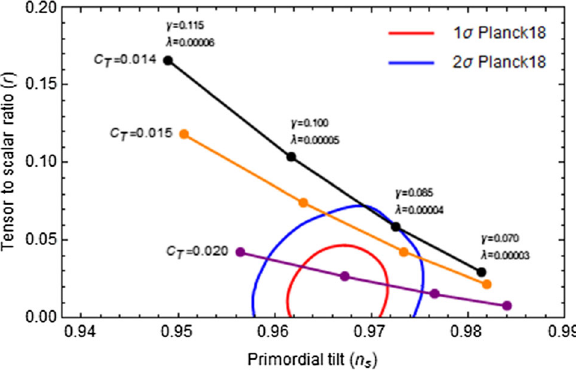
Fig. 2 We compare the theoretical predictions of the strong limit Q > 1 including the growing mode effects Eqs. (43) and (44) for C T = 0 . 020 (purple), C T = 0 . 015 (orange) and C T = 0 . 014 (black) in the ( r − n s ) plane for various values of γ and λ given in Table (1) constrained by the COBE renormalization condition by using C R = 70, ξ = 10 4 , N = 60 and M = 10 (cid:11) with Planck’18 results for TT, TE, p